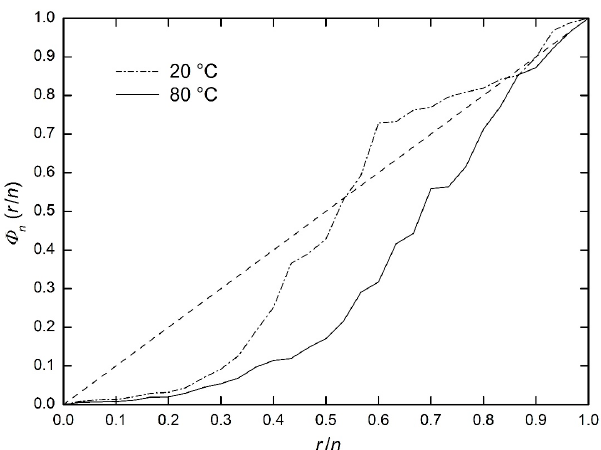
O /SiO capacitors under stress voltage 2 5 2